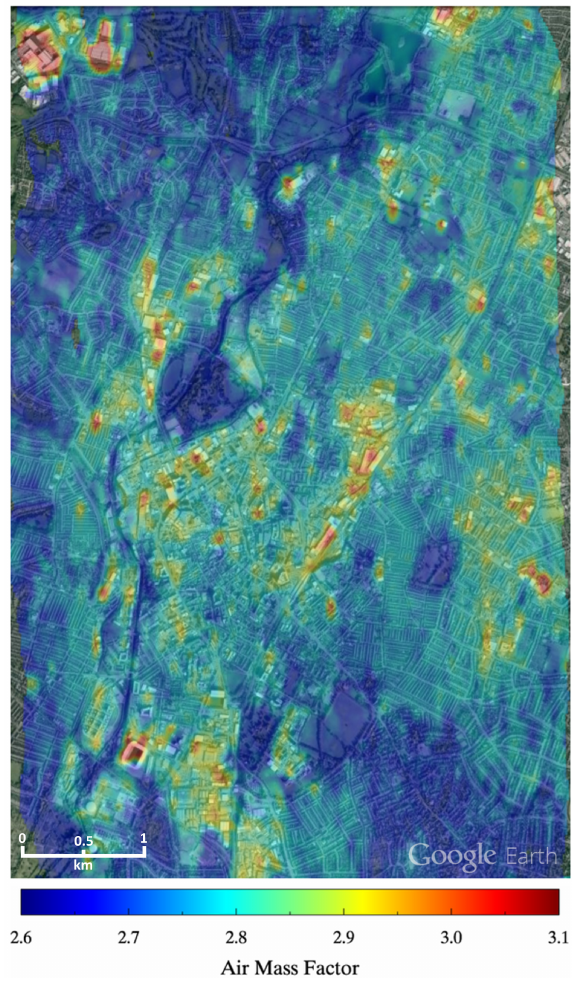
Figure 10. The gridded AMFs calculated for this work, overlaid on Google Earth, showing the sensitivity of the AMF computation to surface albedo. Bright regions such as white roofs result in higher AMFs, while darker regions such as rivers, canals and parkland have lower